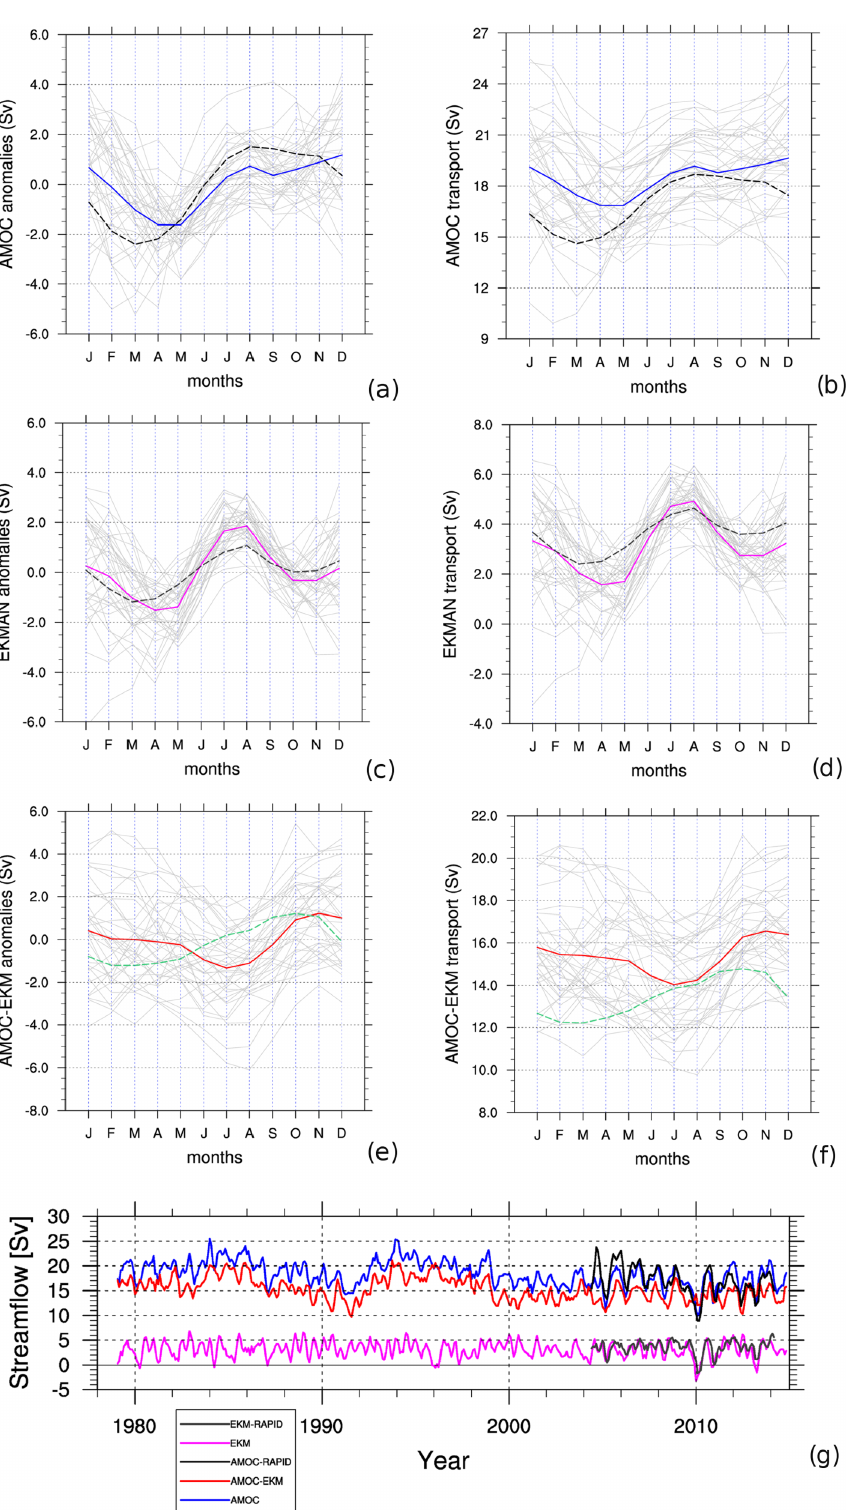
Figure 1. The AMOC in the assimilation experiment. Climatology of the maximum AMOC transport at 26 ◦ N in the assimilation experiment, smoothed with a 3-month running mean and the annual cycle removed (spanning 1979–2014), for anomalies (a, c, e) , and full values (b, d, f) as labelled. The highlighted solid coloured lines represent the mean transport values, whereas each light grey line represents a given year. The dashed lines correspond to the mean value of the observed AMOC. (g) The modelled AMOC at 26 ◦ N (blue line), AMOC-EKM (red line) and EKM (magenta line); the observed AMOC (black line) and EKM as the component in the RAPID data (grey